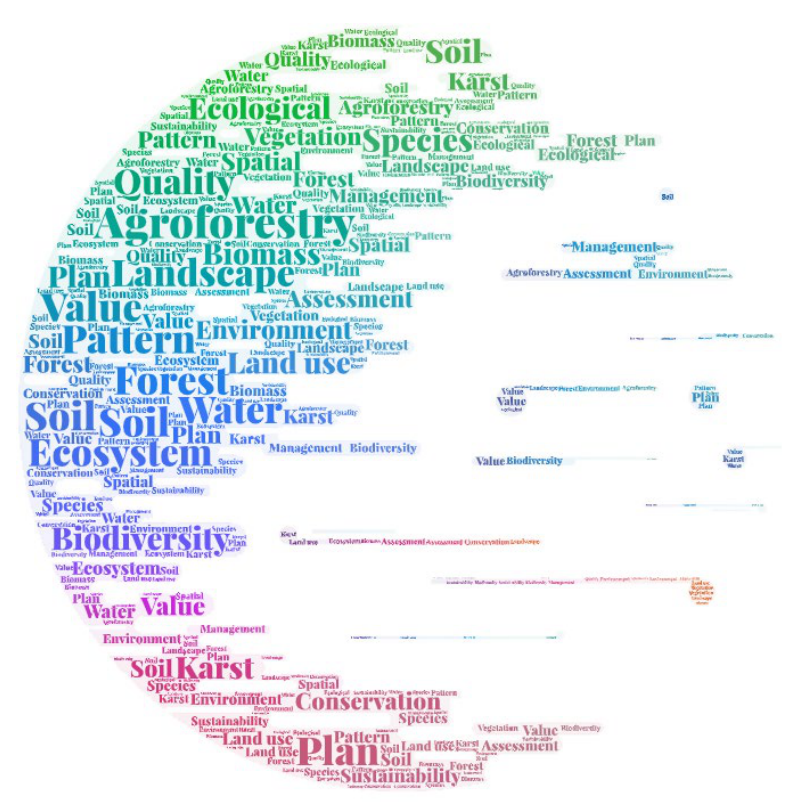
Figure 4. s: word cloud visualization.